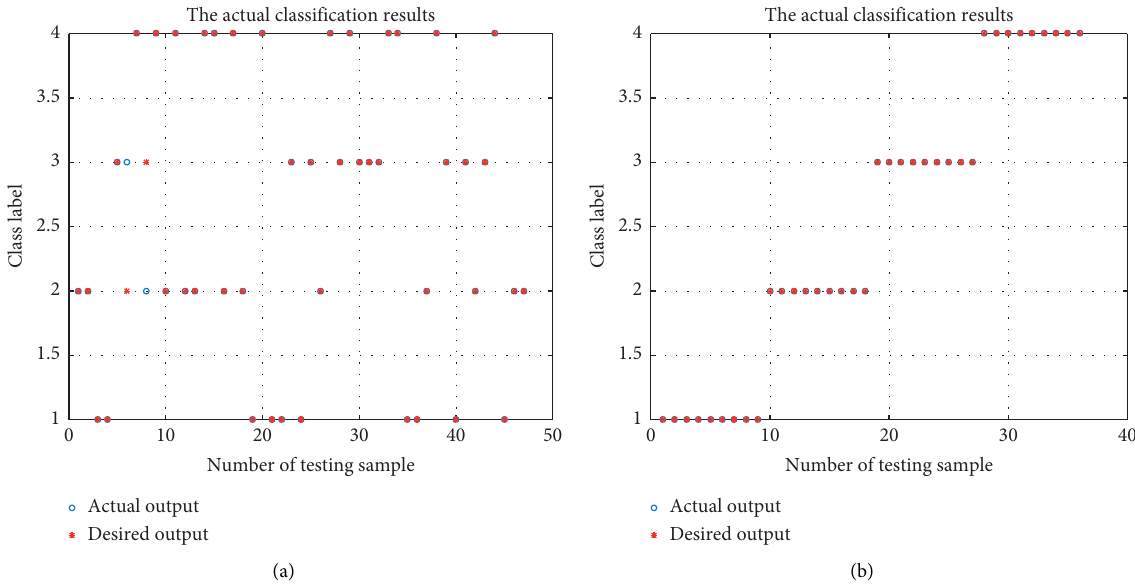
Figure 10: Identification of the numerical simulation based on time-domain energy entropy. (a) SVM model. (b) PSO-SVM